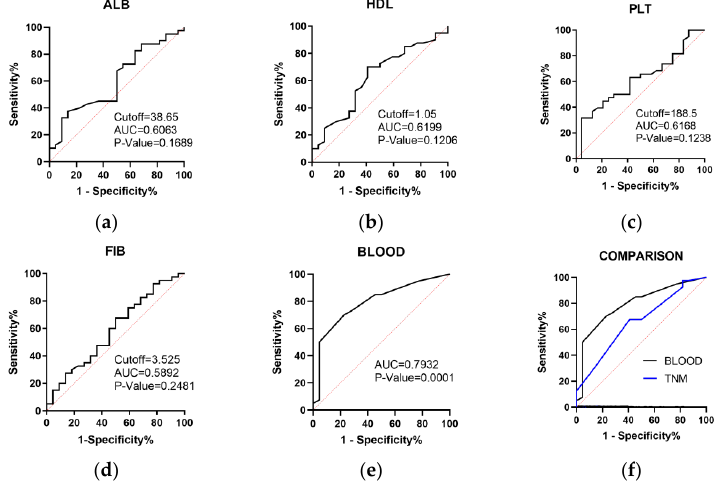
Figure 2. Receiver Operating Characteristic (ROC) analysis of peripheral blood parameters to predict induction chemotherapy (IC) response in advanced laryngeal squamous cell carcinoma (LSCC). ( a – d ) ROC analysis of peripheral blood parameters to predict IC response (AUC > 0.58); ( e ) ROC analysis of the blood model to predict IC response; ( f ) comparison between the blood model and conventional TNM stage model to predict IC response by ROC